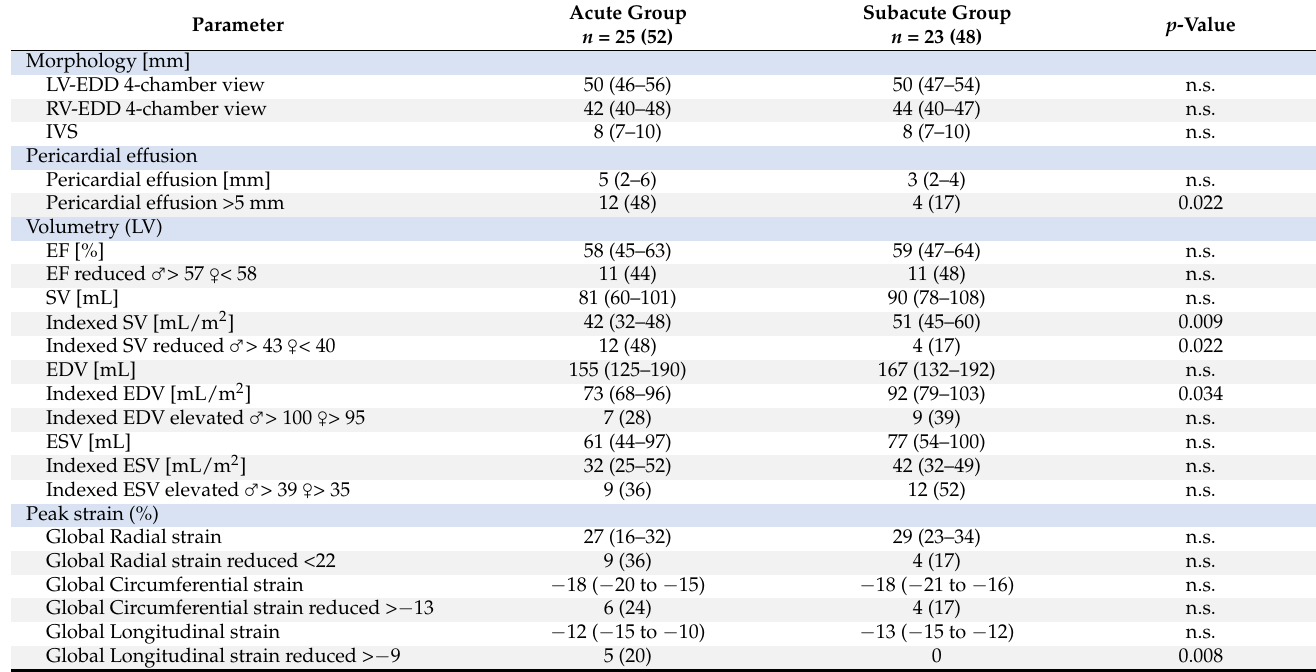
Table 2. CMR results in acute and subacute myocarditis.